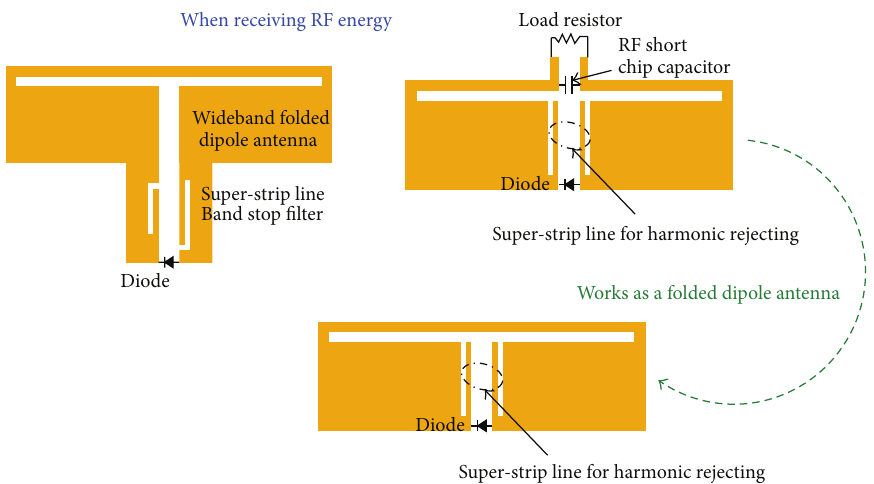
Figure 5: Schematic of proposed novel compact rectenna working to receive the RF